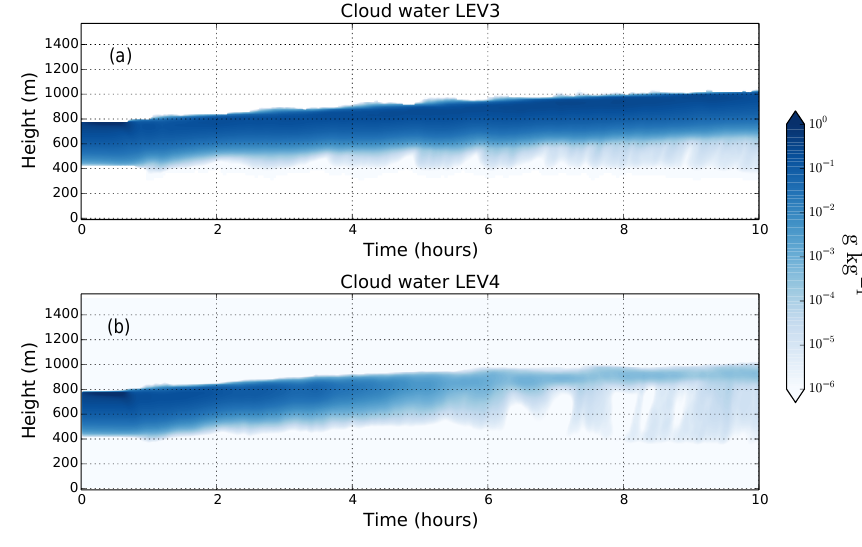
Figure 2. Time–height cross section of the cloud water content for LEV3 and LEV4 simulations in gkg − 1 .